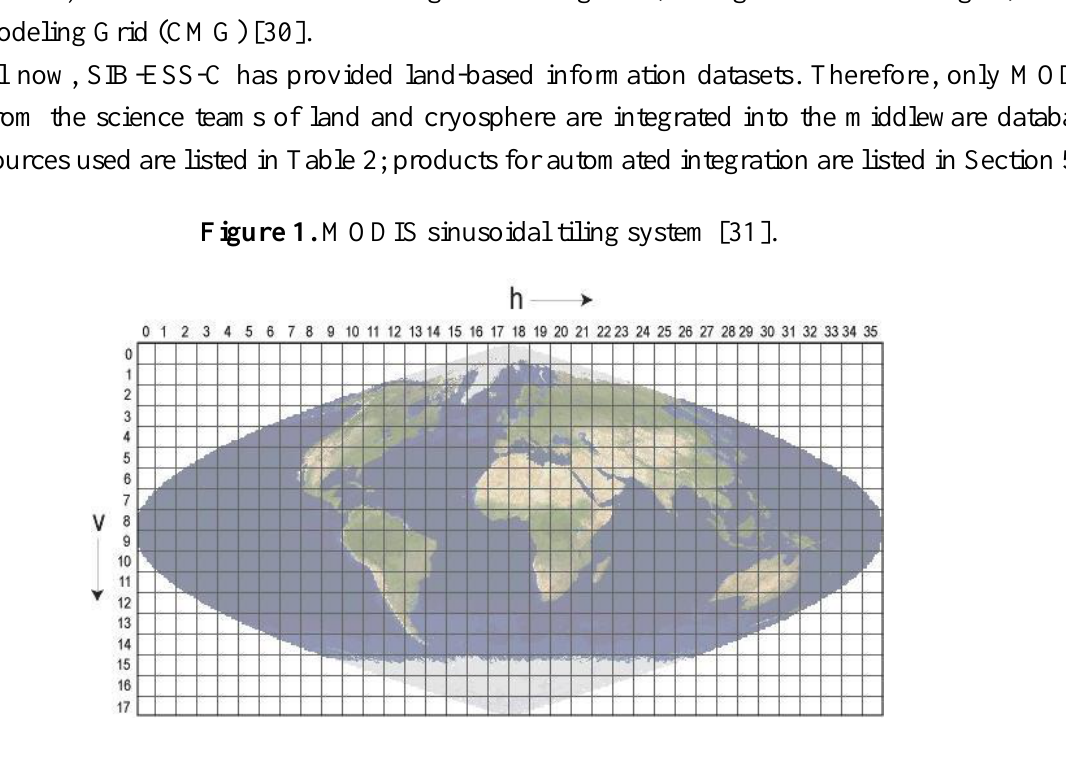
Table 2. Data sources for MODIS land and cryosphere